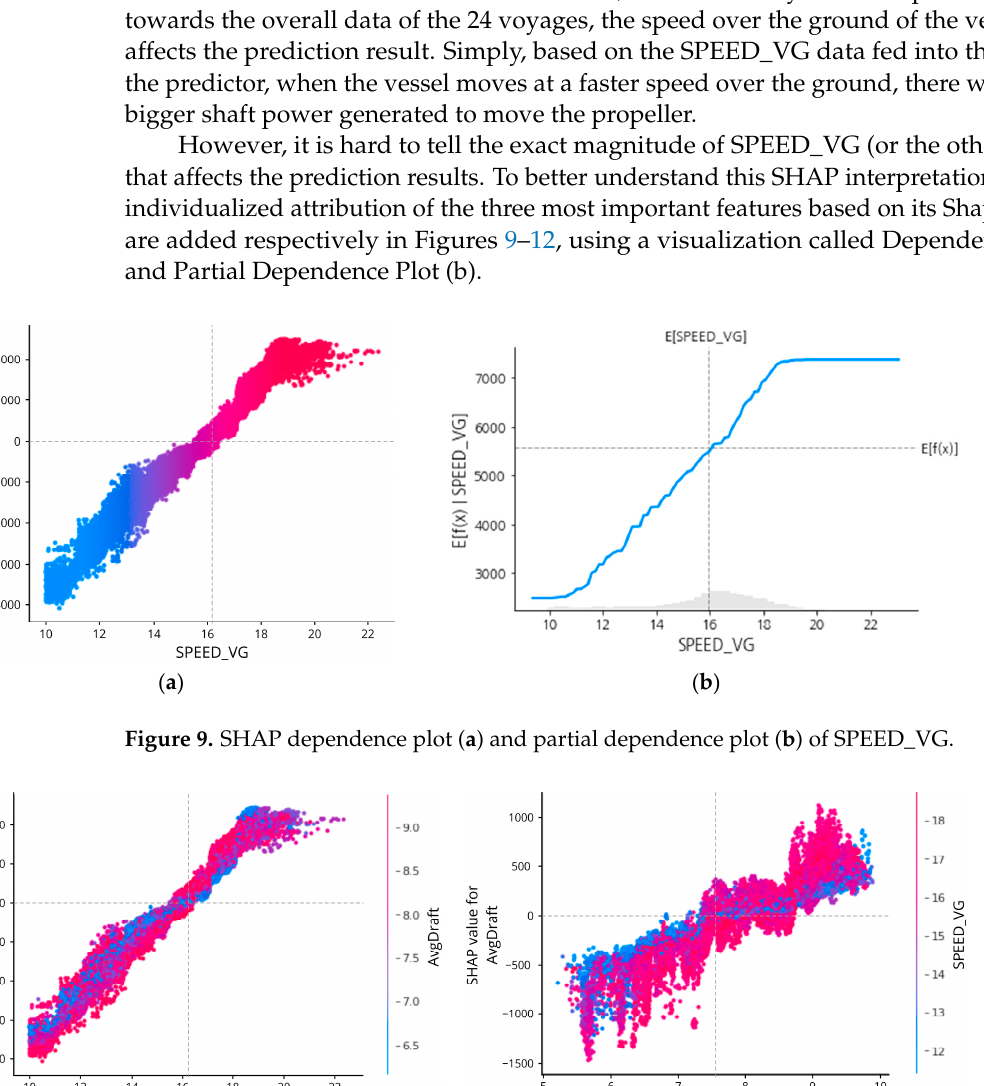
Figure 8. Mean absolute SHAP value bar plot.